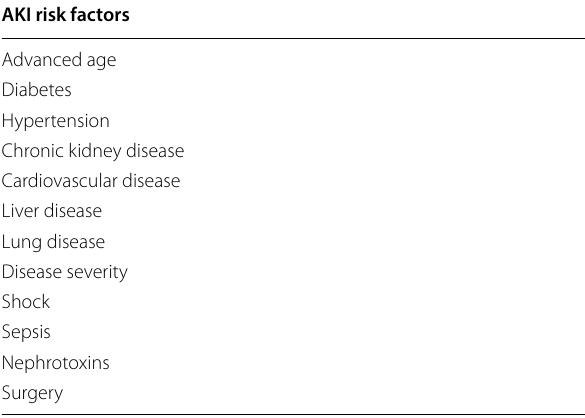
Table 1 Risk factors for AKI